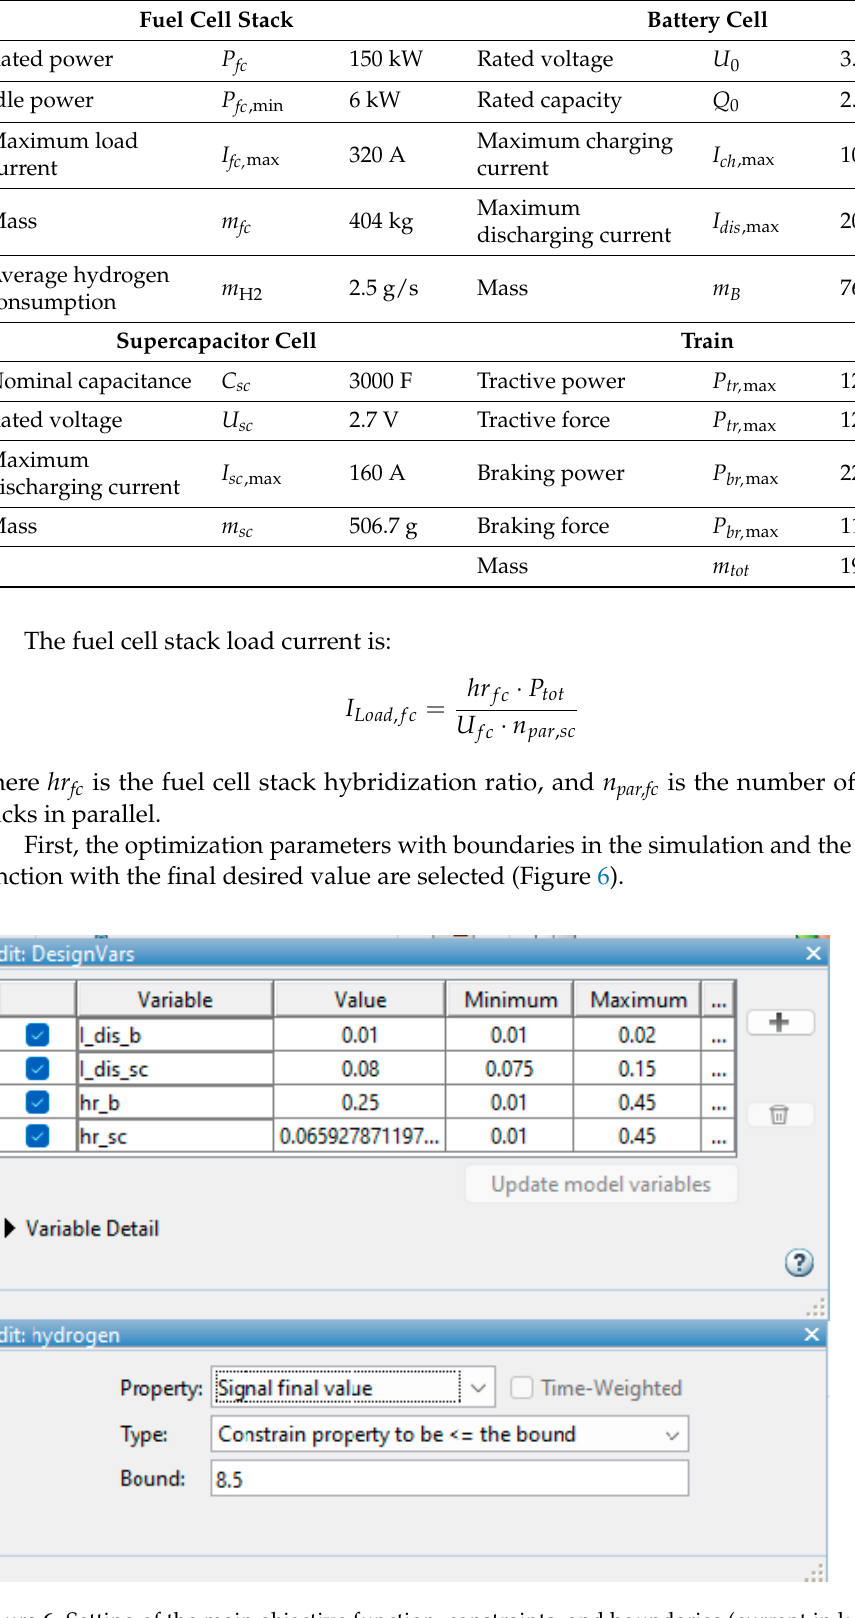
Figure 6. Setting of the main objective function, constraints, and boundaries (current in kA).